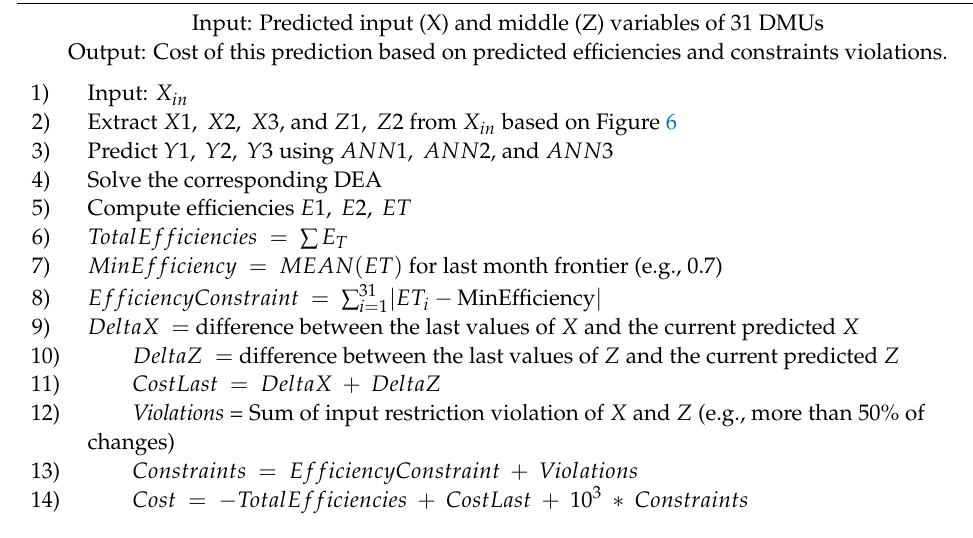
Algorithm 1 . Cost function of the GA.